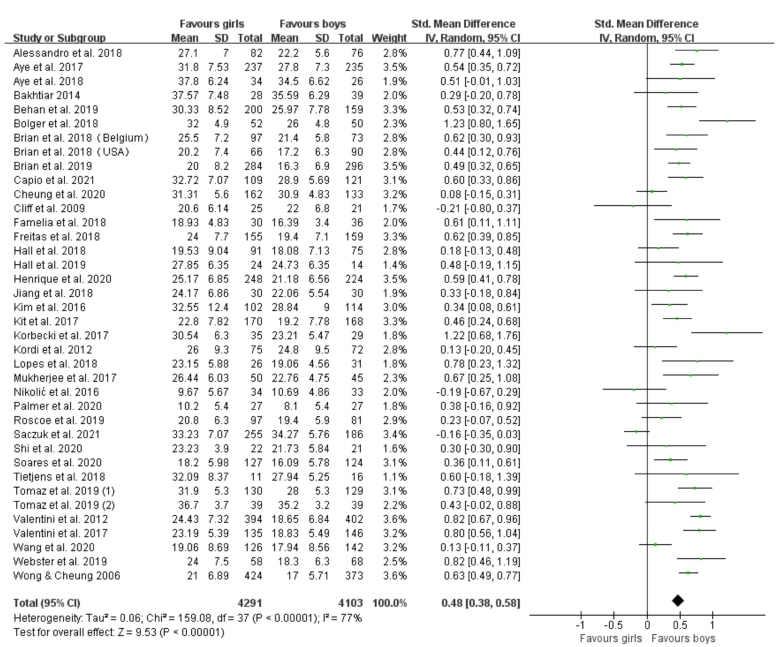
Figure 3. Forest plot of locomotor skills scores [28–57,59–65].